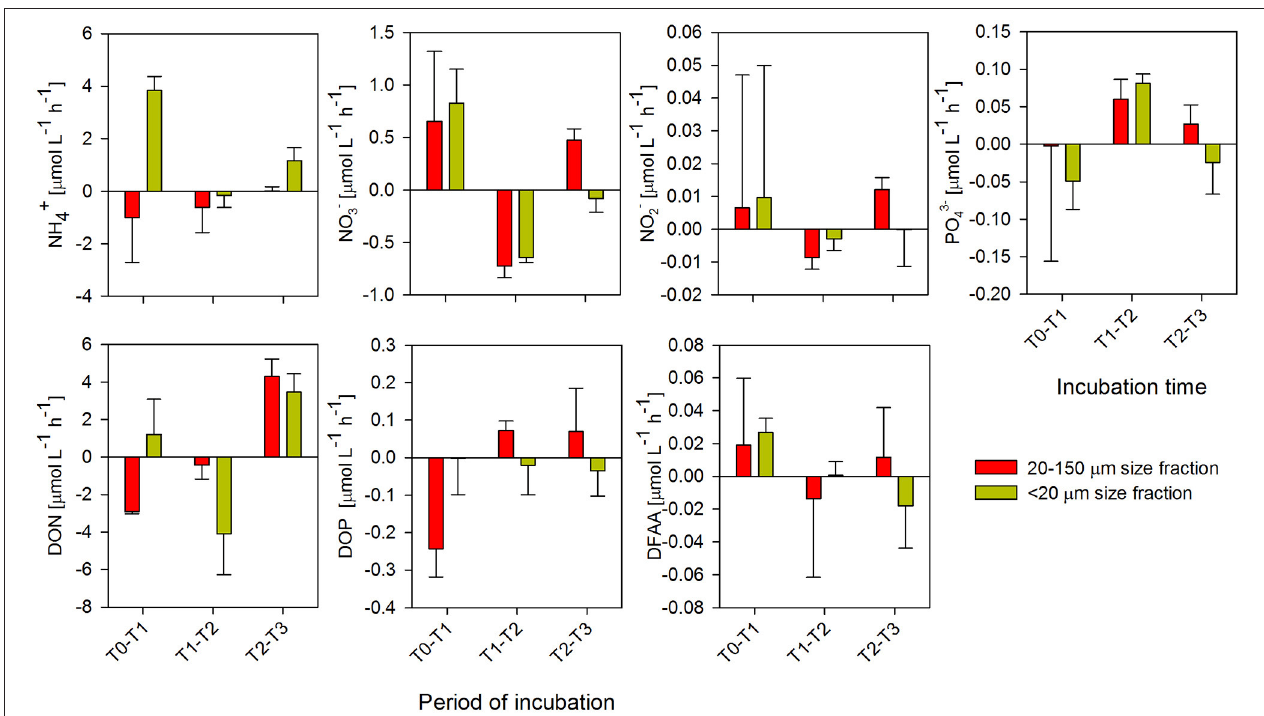
FIGURE 3 | Turnover rates of ammonium (NH + 4 ), nitrate (NO − 3 ), nitrite (NO − 2 ), phosphate (PO 3 − 4 ), dissolved organic nitrogen (DON), dissolved organic phosphorus (DOP), and dissolved free amino acids (DFAAs) estimated for every 2h of incubation, during the microbial response phase in late summer. Each point represents four replicates (mean ± standard